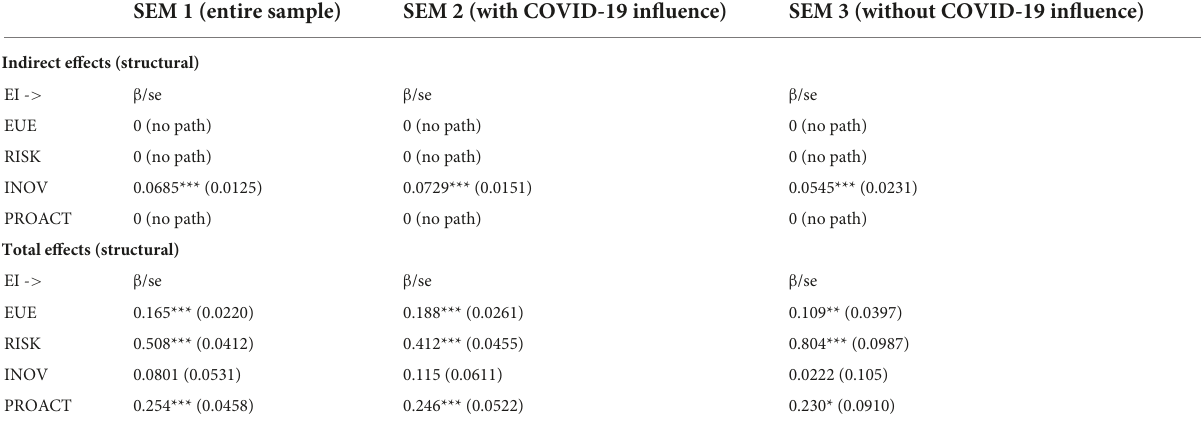
TABLE 2 Indirect and total effects captured in the SEM models by MLE method.